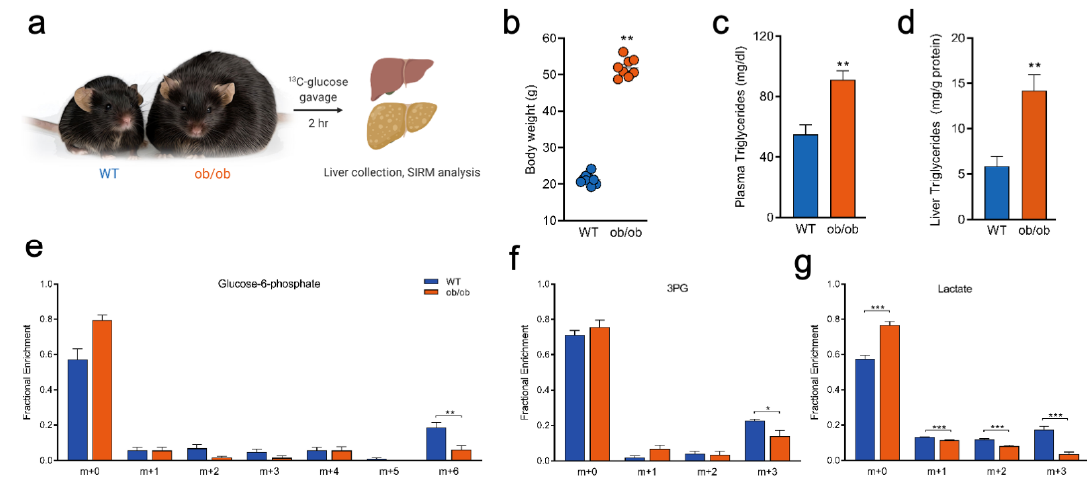
Figure 6. Liver glucose metabolism in the Lep ob / ob (ob / ob) obesity and type II diabetes mouse model. ( a ) Experimental paradigm depicting ob / ob and WT mice receiving oral gavage of [U- 13 C] glucose, 2 h after which tissues and plasma were collected. ( b ) Bodyweight measurement shows greater body mass of ob / ob mice relative to WT. ( c , d ) Triglyceride levels measured via colorimetric assay reveals increased plasma (C) and liver ( d ) triglycerides levels in ob / ob mice. ( e – g ) Fractional labeling patterns in glucose-6-phosphate ( e ), 3-phosphoglycerate (3PG; f ), and lactate ( g ). Values shown are mean ± SEM ( n = 4–5). Data analyzed by unpaired t -test ( b – d ) and unpaired, multiple t -tests ( d - e ). * p < 0.05; ** p < 0.01; *** p <